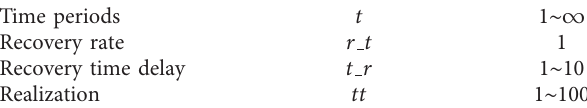
Table 4: Time-dependent part (four